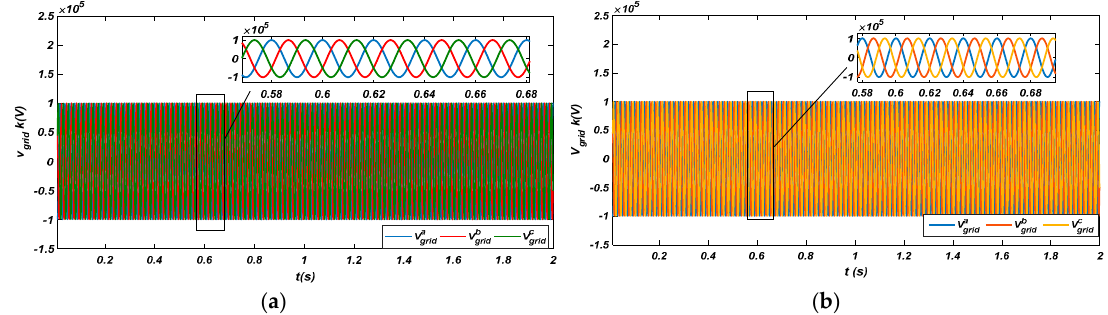
Figure 18. ( a ) Grid phase voltage using the API controller; ( b ) grid voltage using the PR controller.